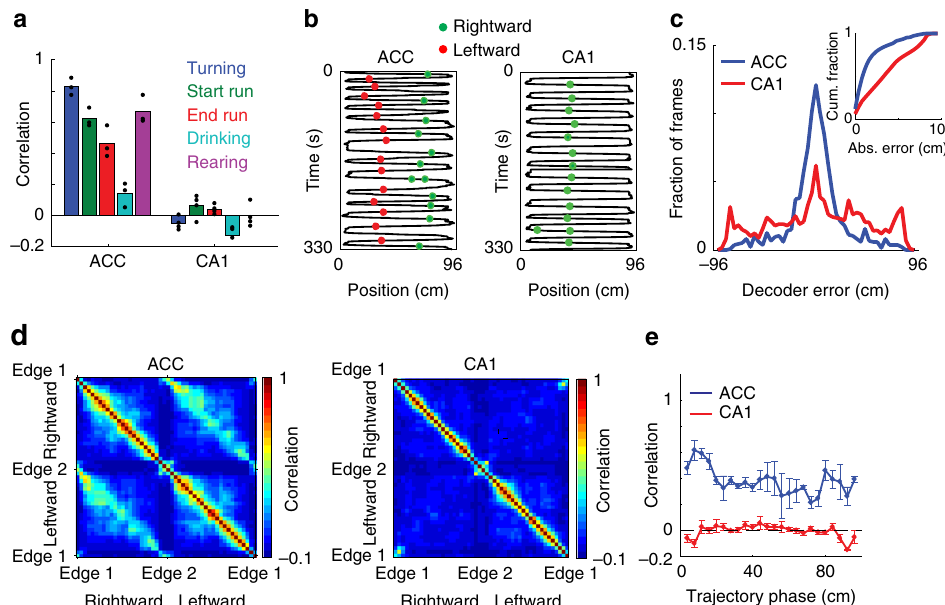
Fig. 3 The different internal structures in the ACC and the hippocampus re fl ect different representations of locations and actions. a Pearson correlation between ensemble activity patterns from the two sides of the linear track, for each behavioral state, for data recorded in the ACC (left) and hippocampal CA1 (right). Ensemble activity patterns consist of concatenated epochs from a given behavioral state on the same side of the track. Data show means for N = 3 mice in the ACC and N = 4 mice in the CA1. b An example trajectory-phase cell recorded in the ACC (left) and an example place cell recorded in the hippocampus (right). The black lines show the positions of the animals, and the green and red dots show the activity of the neurons during rightward and leftward running, respectively. c Distribution of decoding error of trajectory phase for data recorded in the ACC (blue) and CA1 (red). The decoder was trained on data from running in one direction and tested on data from running in the other direction. Inset, cumulative fraction of the absolute decoder error. d Pearson correlation between ensemble activity patterns across different spatial locations on the linear track, for data recorded in the ACC (left) and CA1 (right). Ensemble activity patterns consist of concatenated epochs from a given location, separated according to the two running directions. e Pearson correlation (mean ± SEM) between ensemble activity patterns from the two sides of the linear track, given the same trajectory phase, for data recorded in the ACC (blue) and CA1 (red). Ensemble activity patterns are de fi ned as the mean event rate for each neuron given a spatial bin and running direction. Data in c - e pooled from N = 3 mice in the ACC and N = 4 mice in the